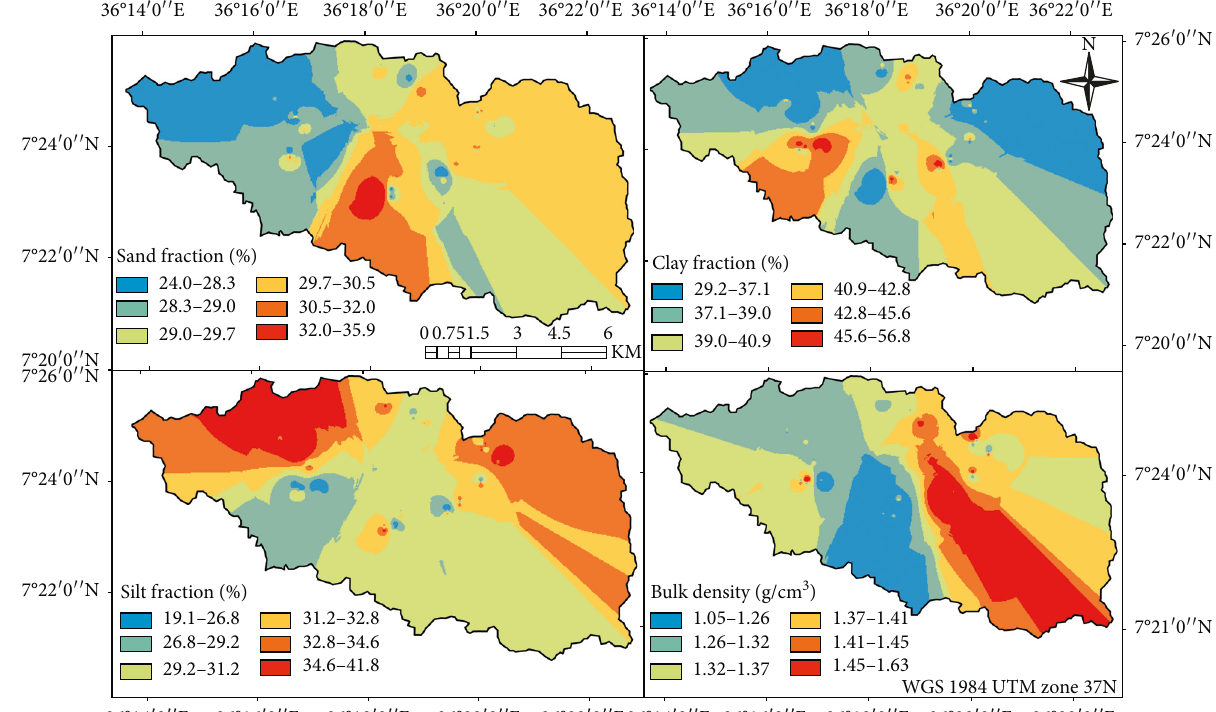
Figure 4: Spatial distribution of particle size distribution (%) and dry soil bulk density (gcm − 3 ) of Geshy